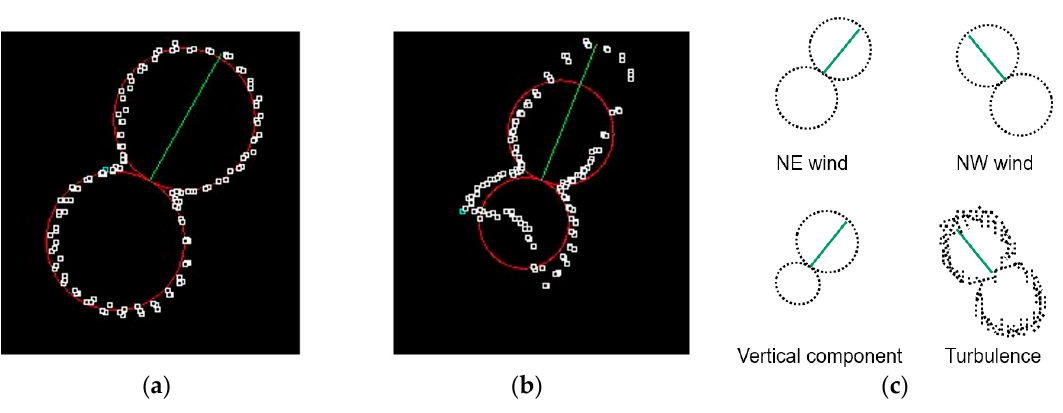
Figure 8. The appearance of Doppler estimates in a polar plot for a conical-scan lidar without direction (+/ − ) discrimination. ( a ) “Figure-of-8” for a steady wind; ( b ) Perturbations soon after the passage overhead of an A320 jet. Data from trials with ZephIR at Birmingham airport; ( c ) Simplified guide to interpretation of “figures-of-8” (with thanks to Dr M Harris). The results from Hill et al. [33] here and in Figures 9a and 10 below are reproduced by permission of QinetiQ Limited.